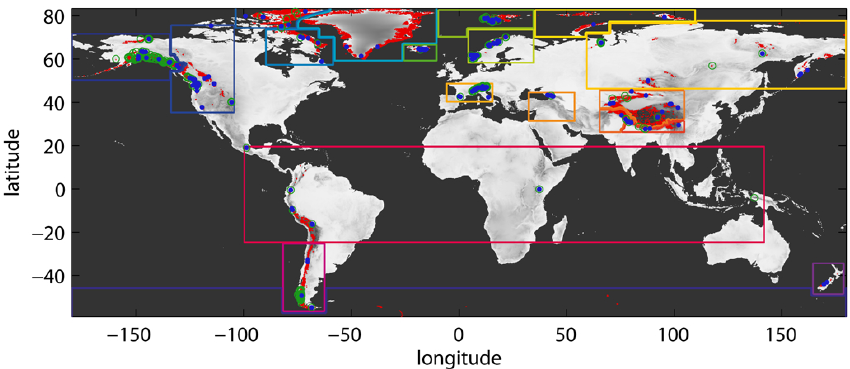
Fig. 1. Red are the outlines of all glaciers included in the RGI and individually modeled in this study. Blue dots indicate the locations of the 255 glaciers used for the cross-validation of the model. Green rings indicate the location of the 341 glaciers used for validation of the modeled, temporally integrated volume and area changes. Colored outlines indicate the boundaries of the regions referred to in the text (see Fig. 2 for the legend).